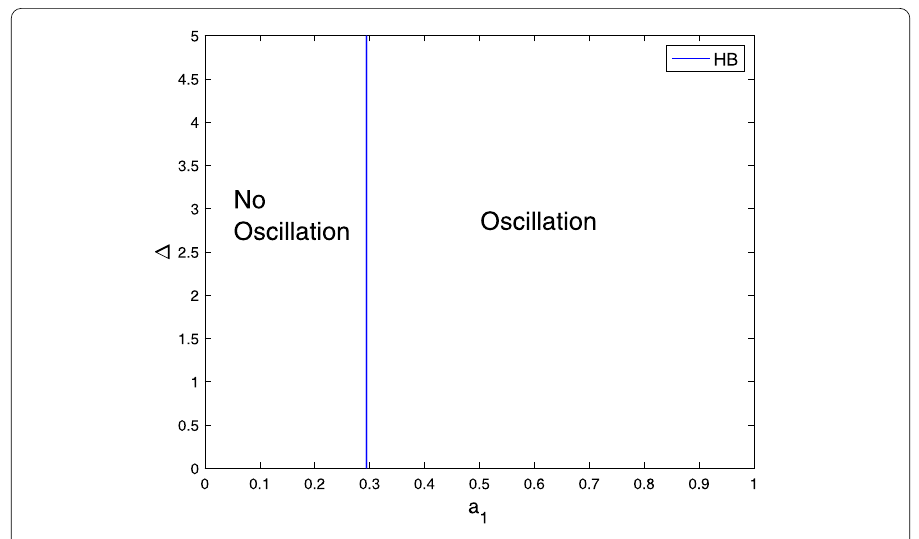
Figure 5 The interplay between a 1 and (cid:5) in order to generate oscillations. Parameter values are similar to Fig. 1